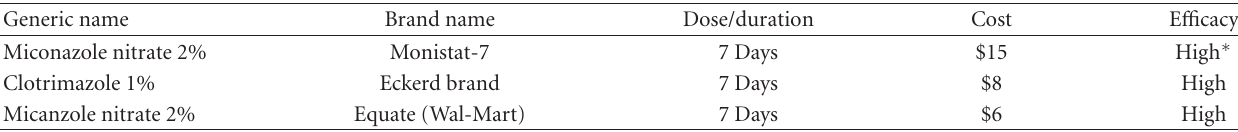
Table 3: Intra-vaginal Imidazoles. Seven-day treatments.